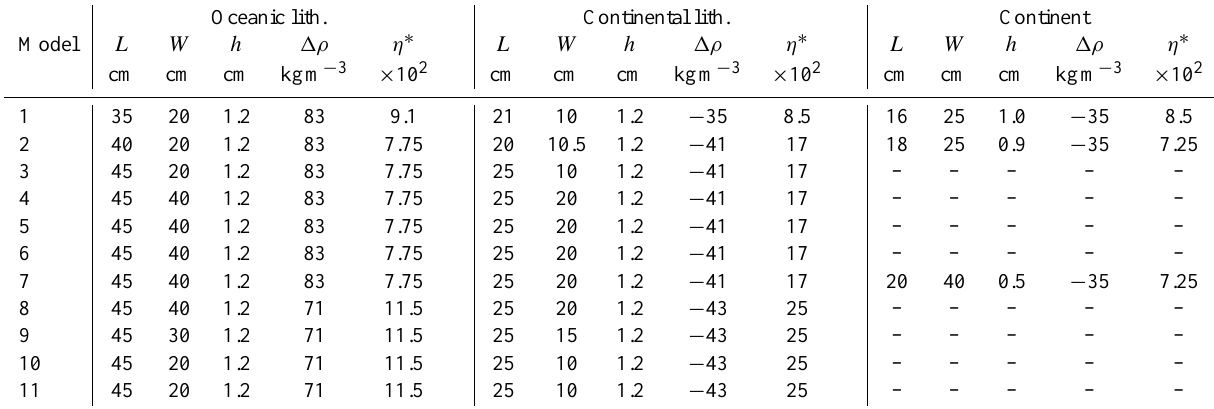
Table 1. Experimental parameters. L : length; W : width; h : thickness; 1ρ : ρ − ρ mantle ; η ∗ : η/η mantle . Considering a natural case with the following parameters ( h slab = 72km; η mantle = 1 × 10 20 Pas and 1ρ slab = 71kgm − 3 ), 1km in nature corresponds to 0.14mm in the lab, a period of 1Myr in nature corresponds to 57s in the lab, and a velocity of 10cmyr − 1 in nature to a velocity of 17.6mmmin − 1 in the lab (models